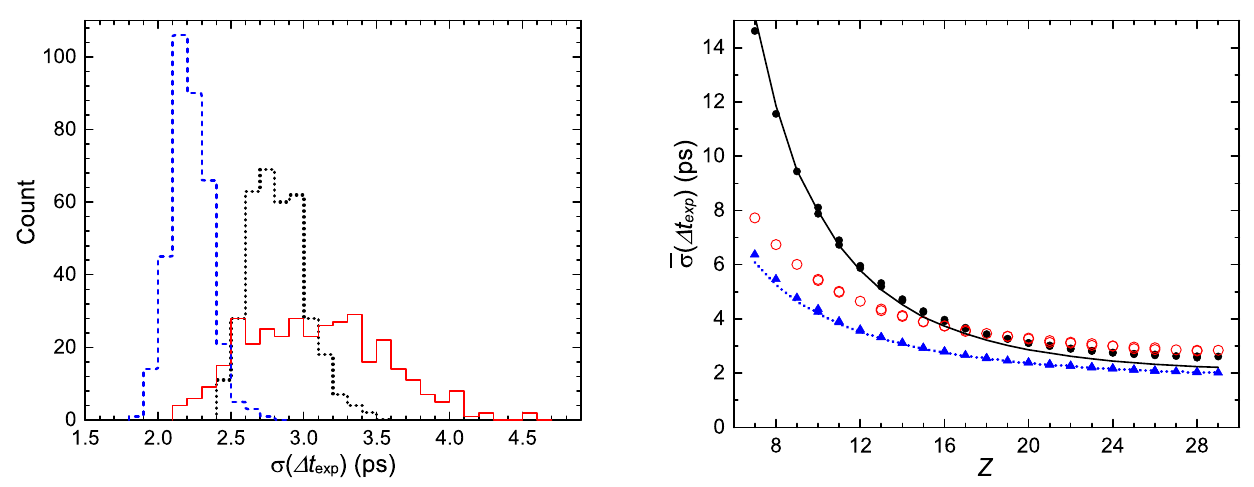
FIG. 10. Uncertainty distributions of Δ t extracted by averaging the time differences, Δ t coincident time stamps in different revolutions (black dotted line), and by using the polynomial fit function with [Eq. (7)] (blue dashed line) and without [Eq. (4)] (red solid line) the sinelike terms.